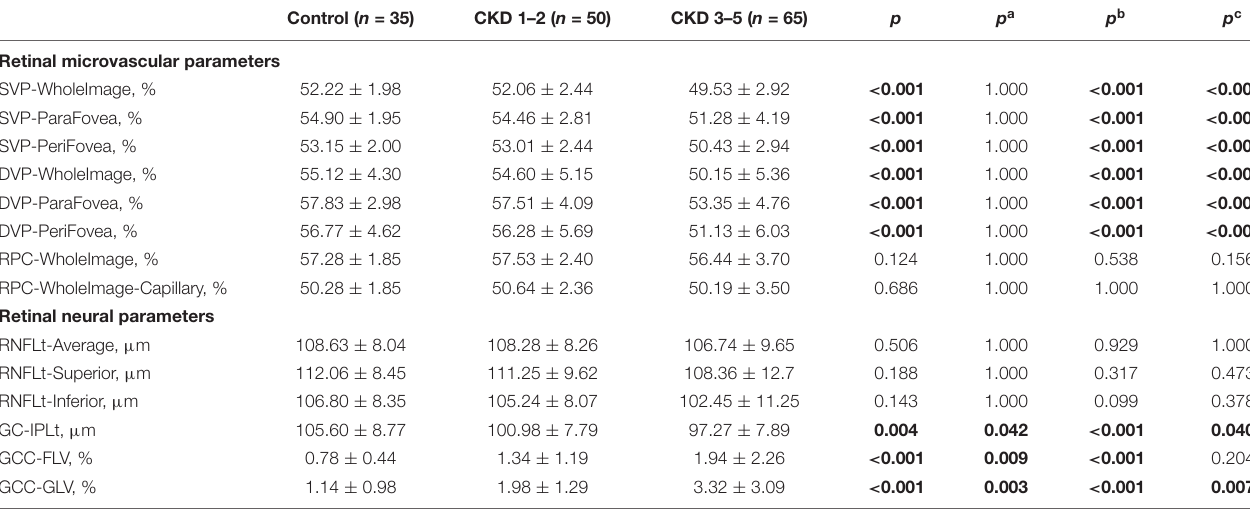
TABLE 2 | Comparison of OCTA parameters among the three